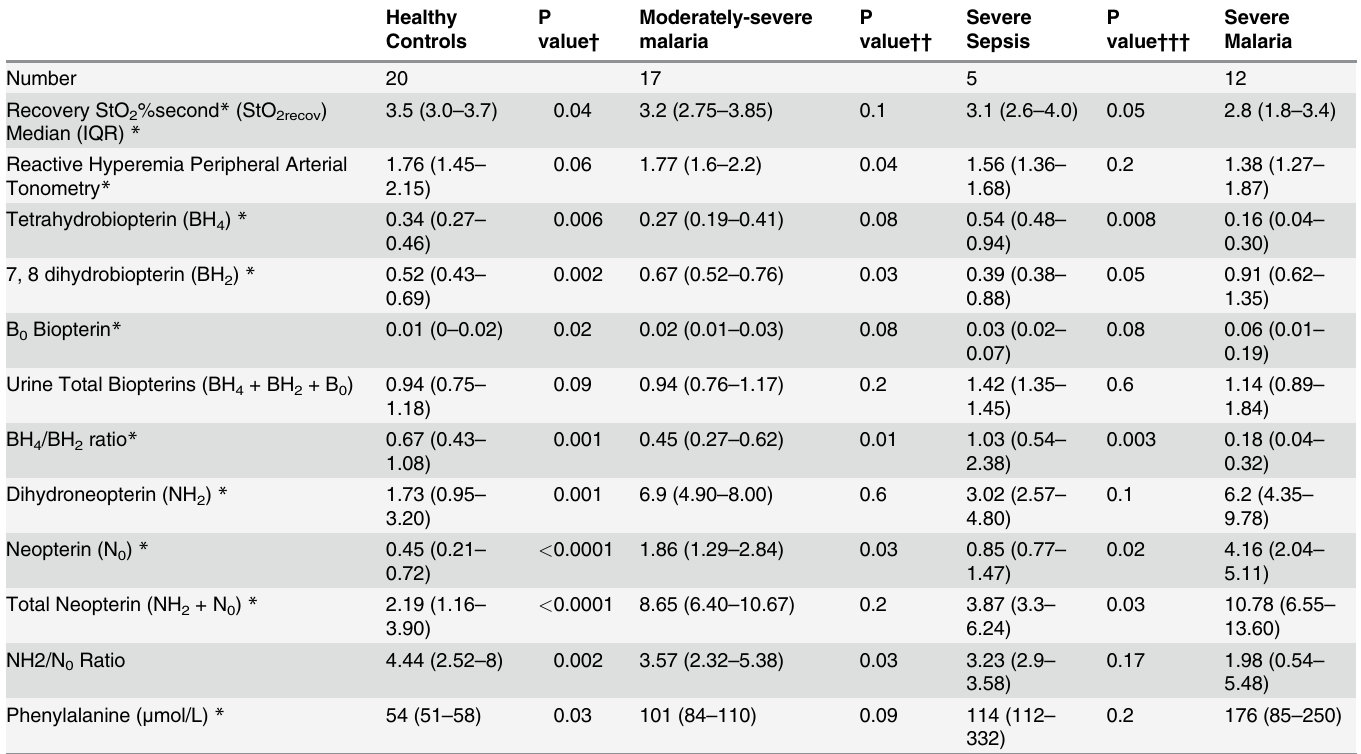
Table 2. Microvascular reactivity, endothelial function and biopterin metabolite values among patient groups.